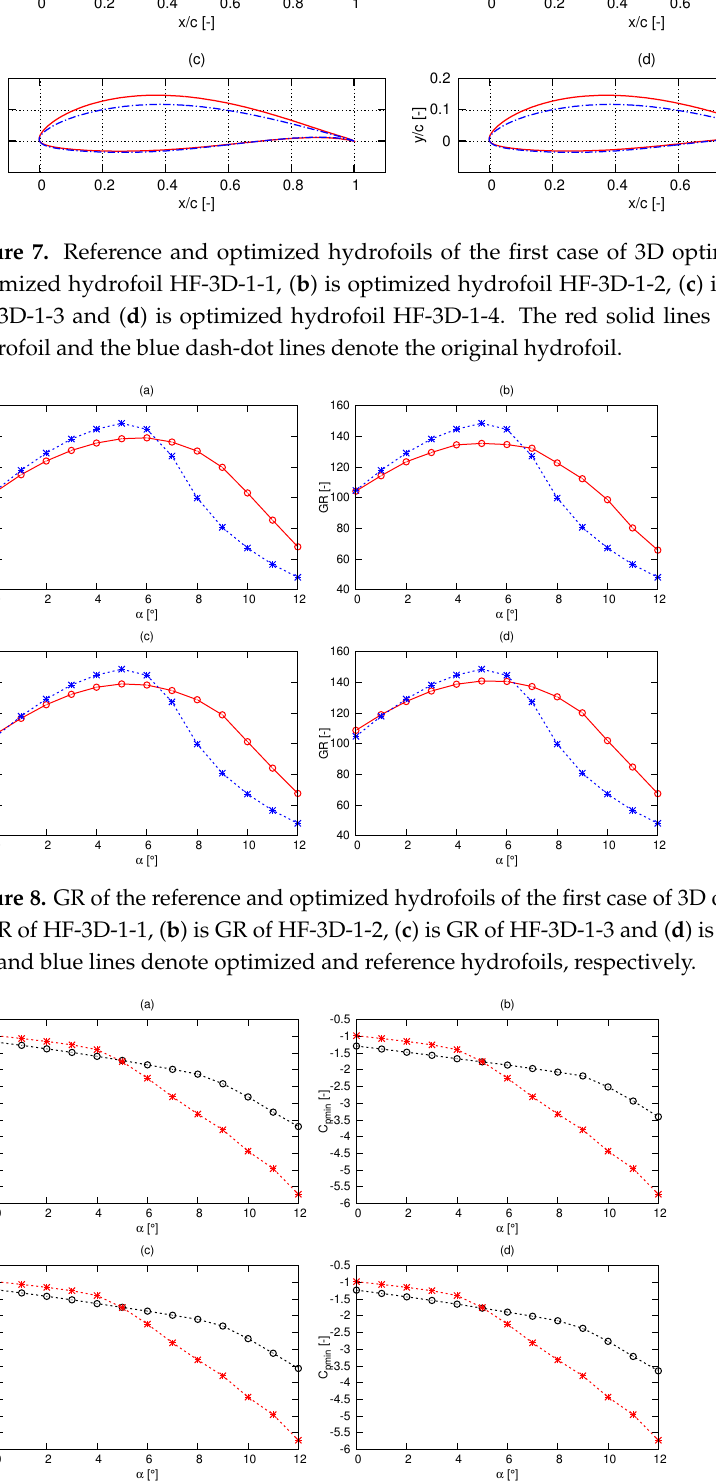
Figure 9. C pmin of the reference and optimized hydrofoils of the first case of 3-D optimization, where ( a ) is C pmin of HF-3D-1-1, ( b ) is C pmin of HF-3D-1-2, ( c ) is C pmin of HF-3D-1-3, ( d ) is C pmin of HF-3D-1-4. The red and black lines denote optimized and reference hydrofoil,